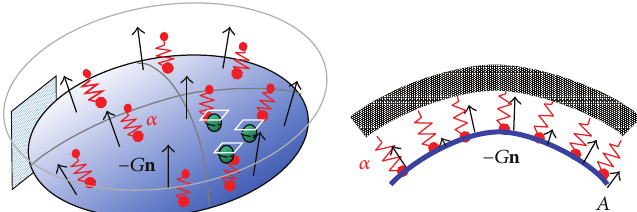
Figure 3: 𝐻 1 gradient method for thin-walled structure under Robin boundary